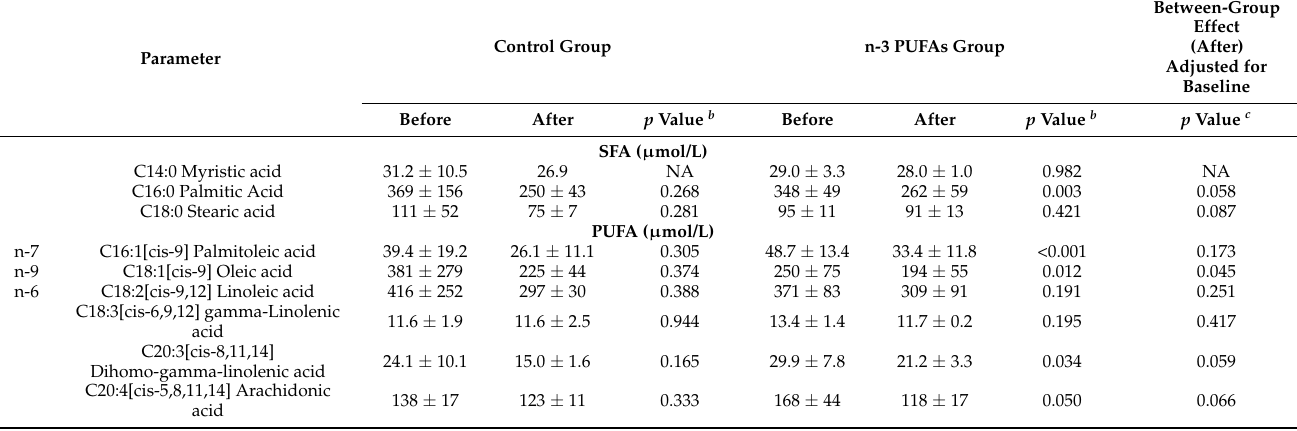
Table 5. Effect of regular (control group) and n-3 PUFA-enriched hen eggs (n-3 PUFAs group) consumption on serum free fatty acid profile in cardiovascular (CAD)